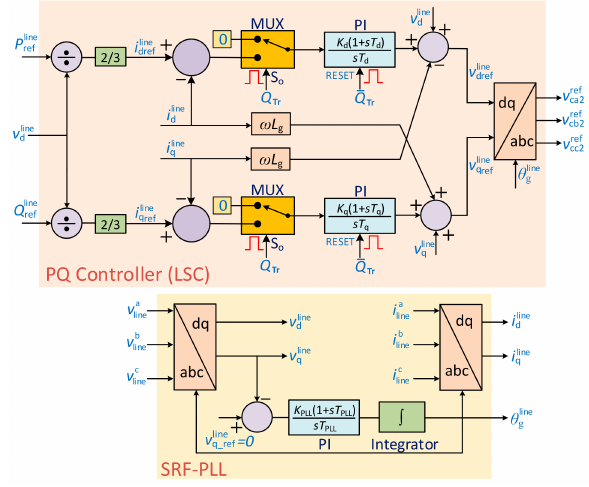
Figure 11. Block diagram of modified PQ controller for LSC operation.